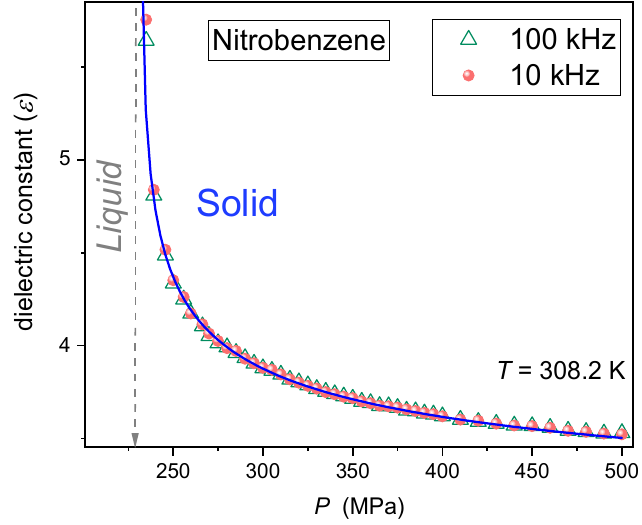
Figure 4. Pretransitional anomaly of dielectric constant appearing for isothermal compressing in nitrobenzene. Experimental data are for two measurement frequencies indicated in the figure. The solid curve portraying the effect is described by Equation (10) with the following parameters: amplitude A = 3.72 K − 1/4 , singular pressure P ∗ = 213 MPa, the exponent ψ = 1/4, and C = 2.580. Note the overlapping of experimental data for two strongly different measurement frequencies, which proves that studies were carried out in the static domain, defining a di- electric constant, for the whole range of the pretransitional effect, reaching ∆ P ∼ 280 MPa. Broadband dielectric spectroscopy studies enable insight also into dynamic